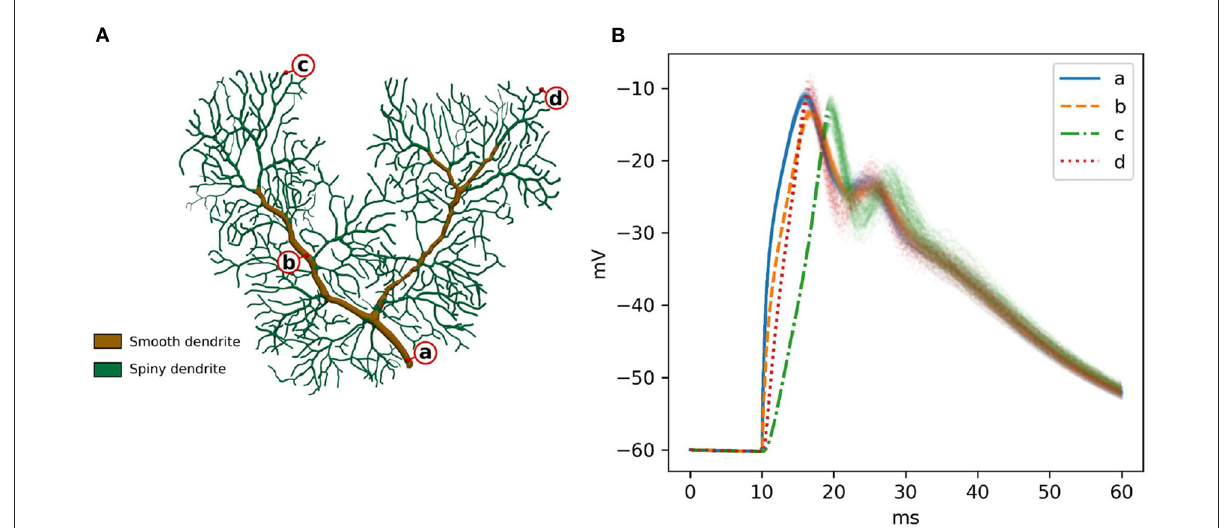
FIGURE6 (A) The Purkinje dendrite mesh reconstruction for both calcium burst models. The mesh consists of 853,193 tetrahedrons. Dendrite elements are further classified and annotated into two components, representing smooth dendrite and spiny dendrite. (B) Raw voltage traces for 100 runs of STEPS 4 at the four different spatial locations indicated by a–d in (A) . After the first depolarization to ~18 ms the systems starts to behave stochastically coinciding with calcium-activation of potassium channels.